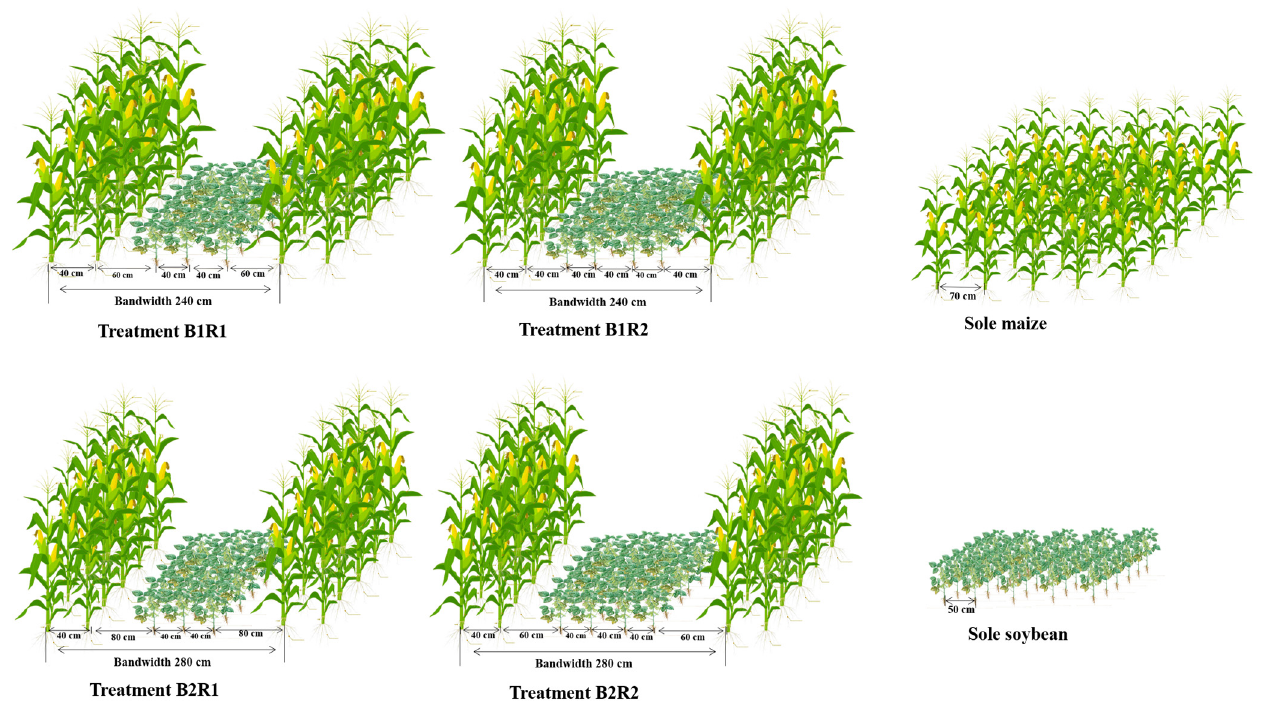
Figure 2. Schematic illustrations of different bandwidth and row ratio configurations. Four different intercrop treatments (B1R1, B1R2, B2R1, and B2R2) and two different sole treatments (sole maize/sole soybean). Two belt crops were planted in one plot, each belt consisted of two rows maize and three or four rows soybean. Table 2. Field configuration test design of different bandwidth and row ratio. (Unit: cm). Treatments